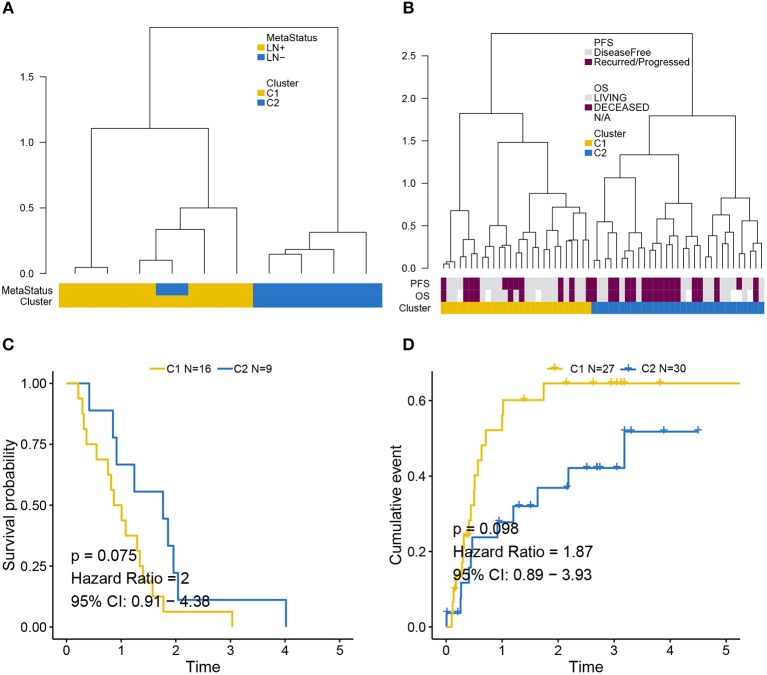
Validation of LNM signature via supervised clustering. (A) Dendrogram created by supervised hierarchical clustering using the GEO cohort significantly distinguished LN metastasis status (p = 0.048) and a dendrogram created for the MSKCC cohort in (B) identified two clusters with a tendency whereby LNM signature was associated with (C) OS (p = 0.075) and (D) PFS (p = 0.098). Cluster C2 was regarded as reference when calculating HR.